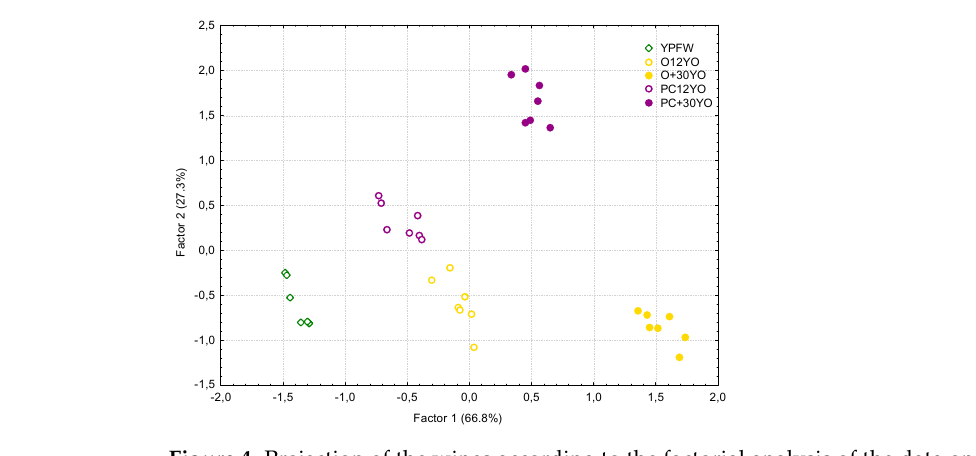
Figure 4. Projection of the wines according to the factorial analysis of the data on the plane formed by Factors 1 and 2.